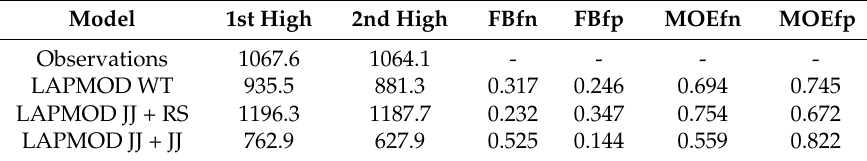
Table 2. Performance statistics for the Indianapolis observations of best quality (Part 2).